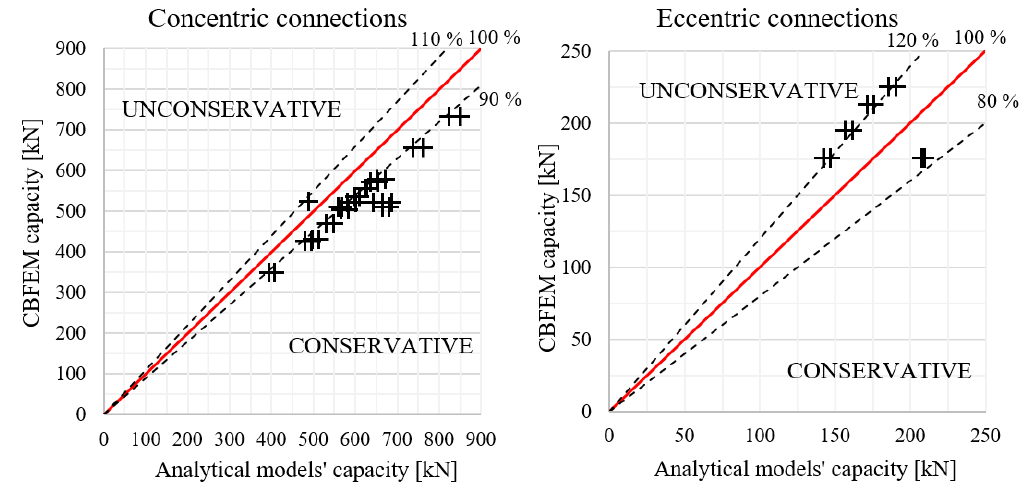
Figure 20. Comparison between analytical models and CBFEM.